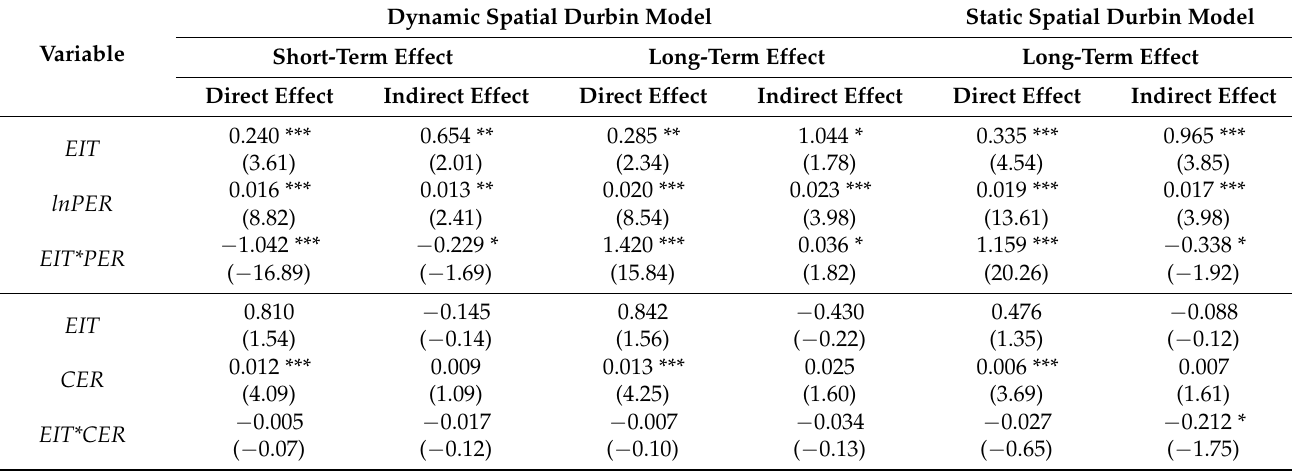
Table 5. Spatial effect decomposition results of the